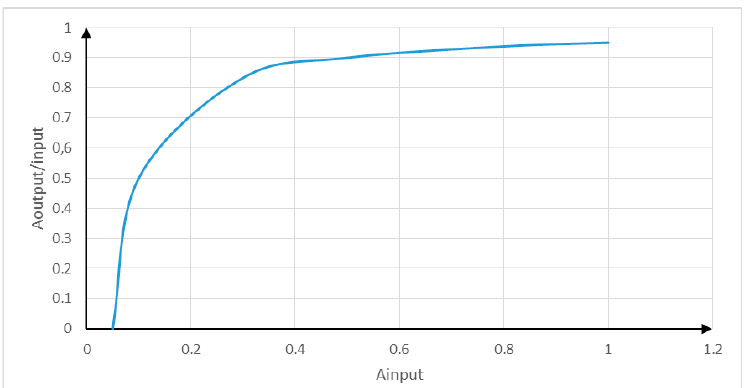
Figure 21. Graph of the output signal amplitude ratio to the input signal amplitude on the ampli- tude of the input signal.